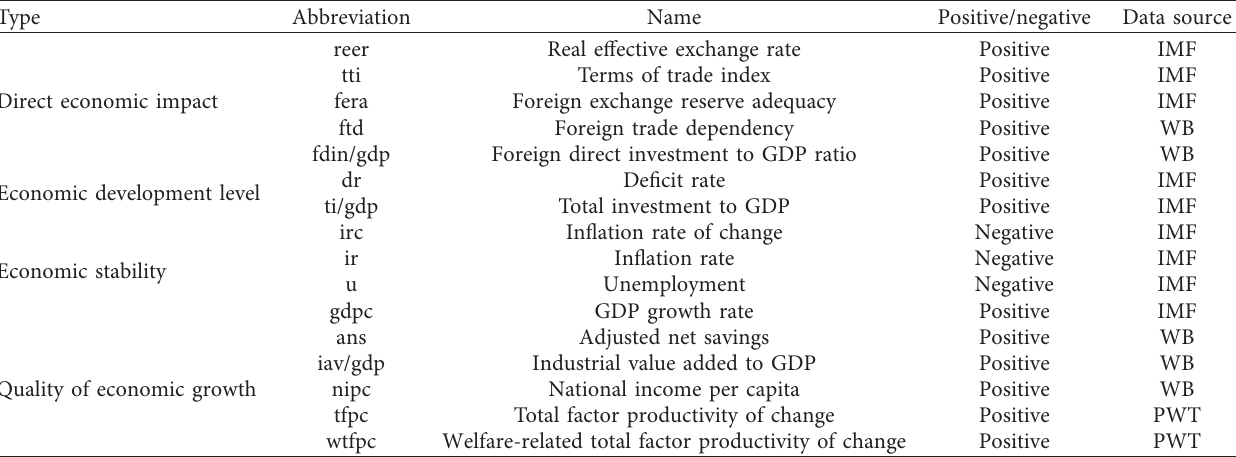
Table 1: Resilience system construction